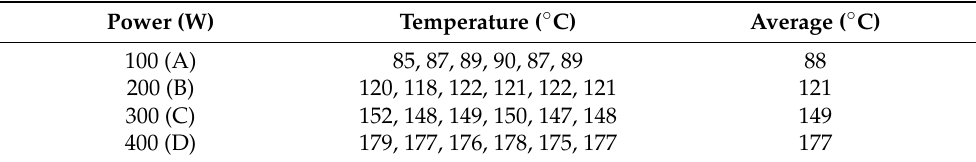
Margin of error of 2 ◦